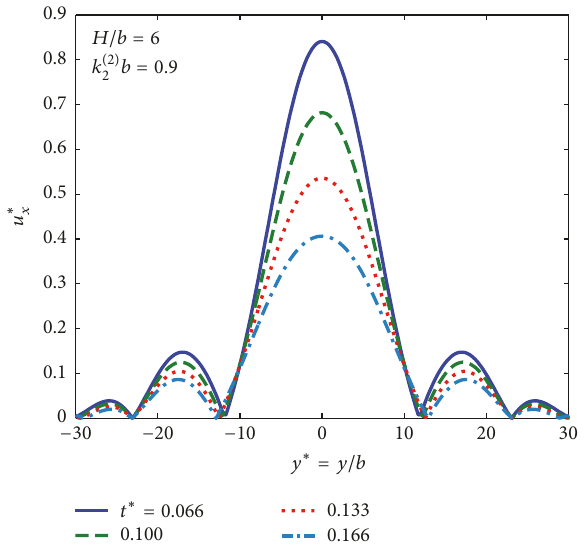
Figure 18: Vertical displacement (𝑢 ∗ 𝑥 ) at the free surface of the half space for different thicknesses (𝑡 ∗ ) for a tunnel in hard